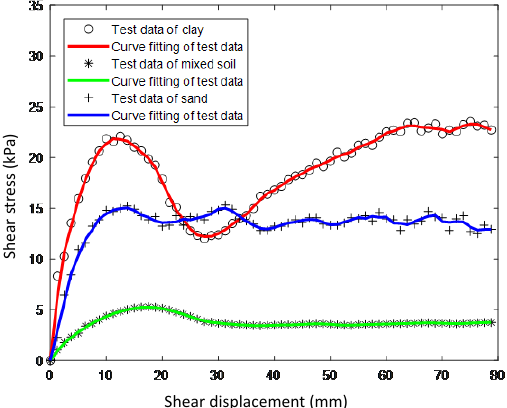
Figure 17. Shear test data and curves of three types of soil.